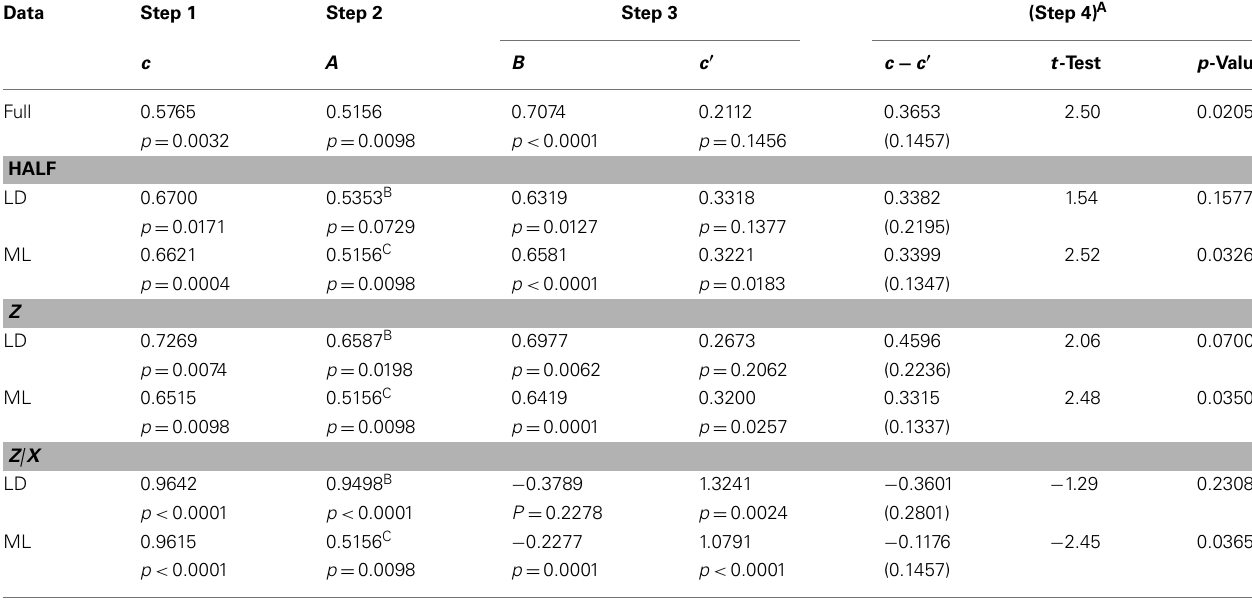
Table 2 | Results from analyses of data inTable 1 using listwise deletion (LD) and maximum likelihood (ML) based the three sampling